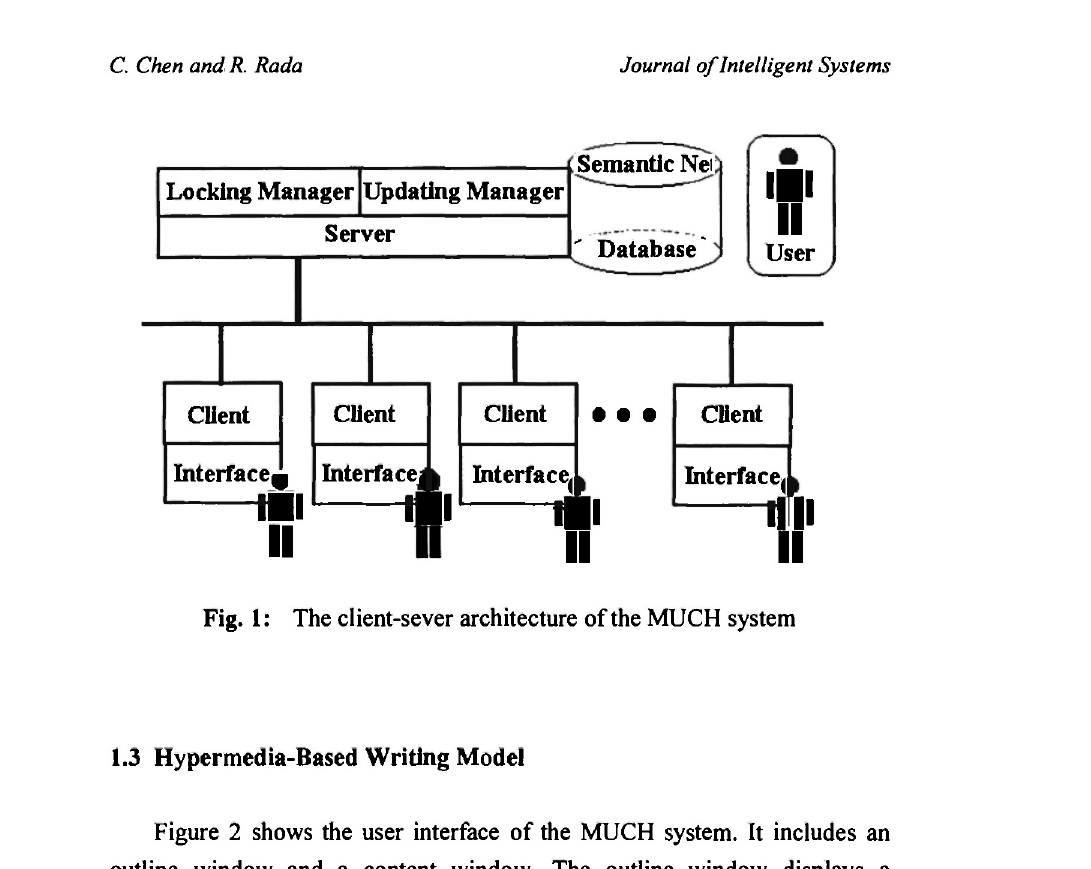
Fig. 1: The client-sever architecture of the MUCH